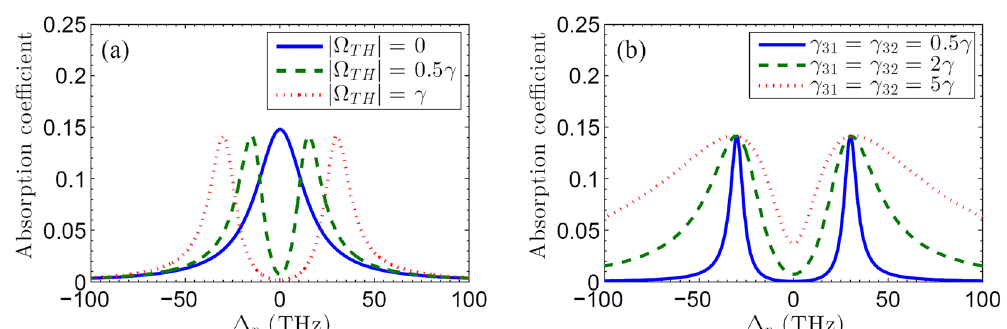
Figure 4. Contour maps of the absorption − Ω Ω z t t 1 ( , )/ (0, ) as a function of the probe frequency p p ν ω π = /2 and the magnetic field intensity B . ( a ) In absence of the THz switch pulse (i.e., Ω = 0 p p presence of the THz switch pulse (i.e., γ Ω = ). Other parameters are given as γ 31 = γ 32 = γ , γ = 3 × 10 13 s − 1 , TH = 0.05 γ , γ Ω = . 0 05 γ , Δ p = 0, Δ TH = 0, and Δ z = 0.34 nm. 21 p